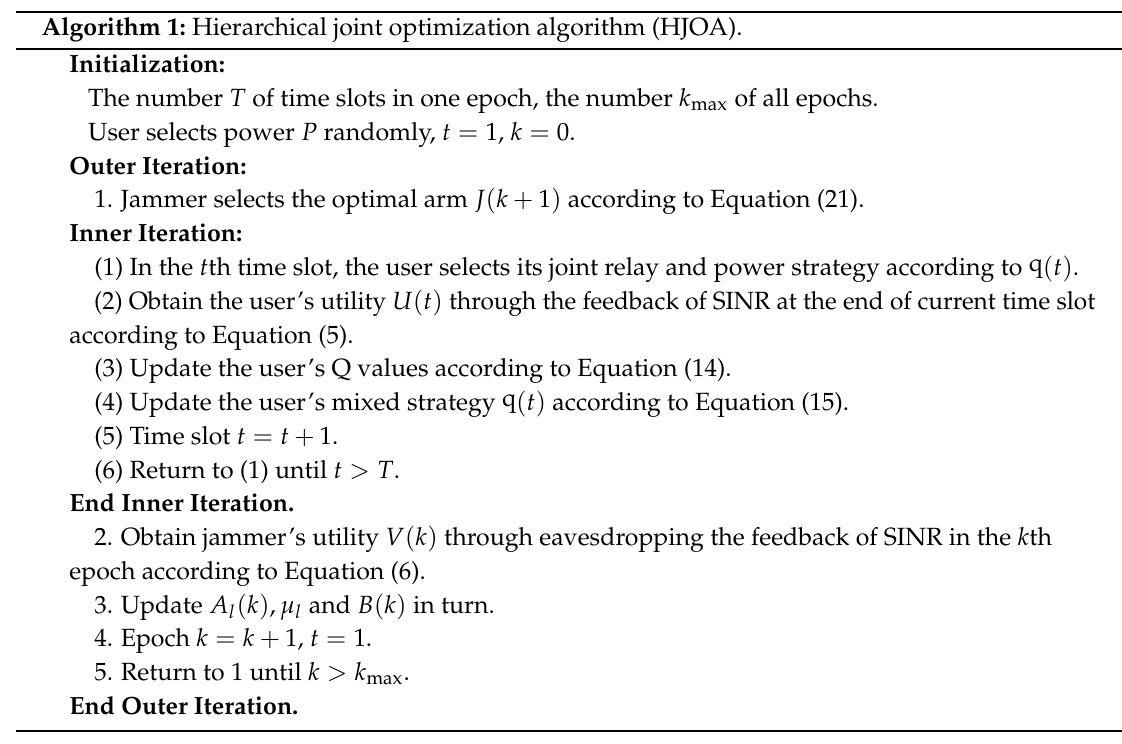
Algorithm 1: Hierarchical joint optimization algorithm